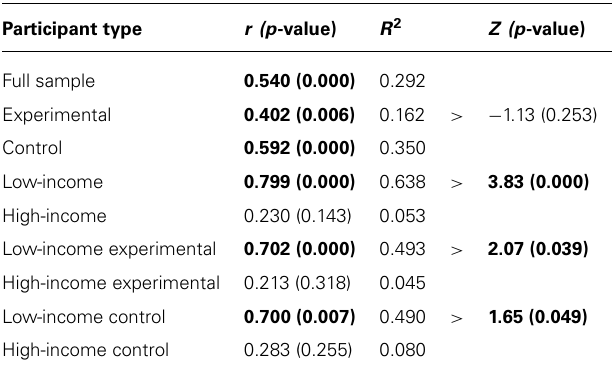
Table 2 | Correlations between reading comprehension scores and SVA immediate posttest scores for various participant